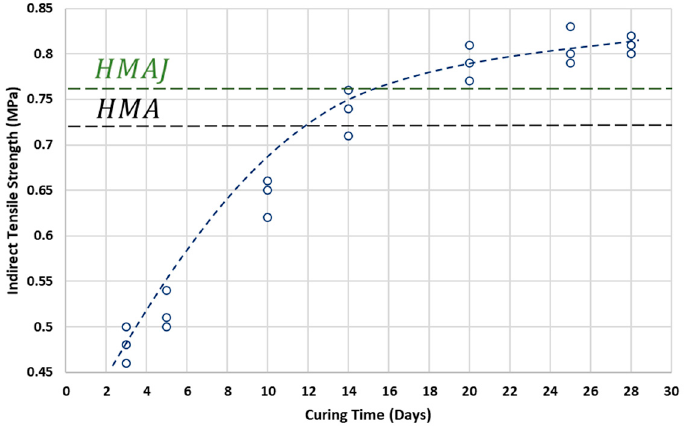
Figure 16. Dry ITS evolution of CRAJ solution with curing time.